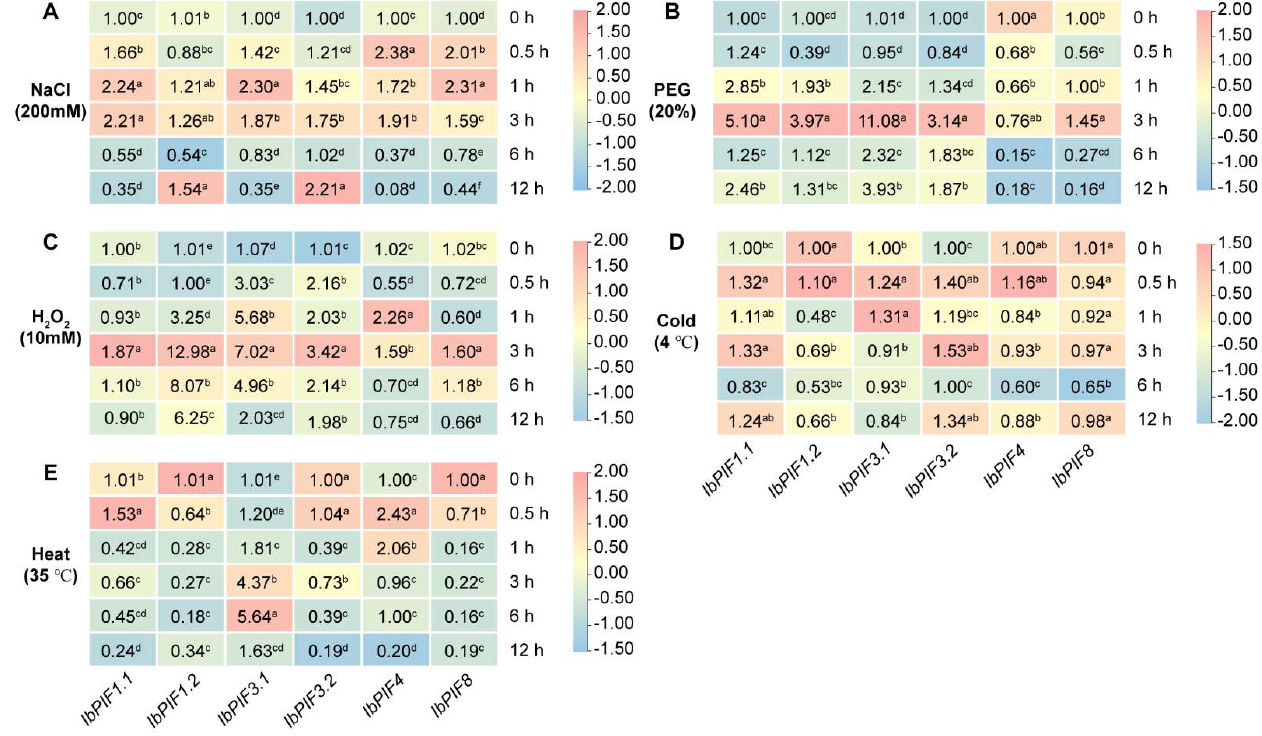
Figure 8. Gene expression patterns of IbPIFs of I. batatas in response to abiotic stresses: ( A ) NaCl; ( B ) PEG; ( C ) H 2 O 2 ; ( D ) cold; and ( E ) heat. The values were determined by qRT-PCR from three biological replicates consisting of pools of three plants, and the results were analyzed using the comparative C T